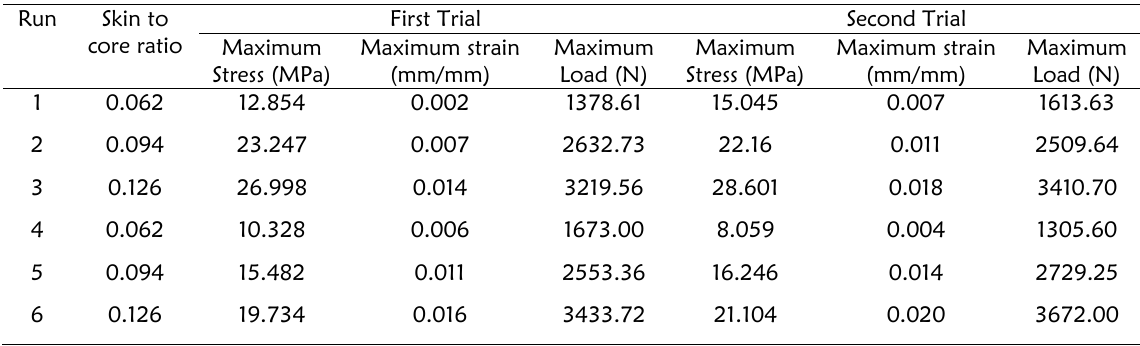
Table 3: Data compilation of tensile test on AFS for first and second